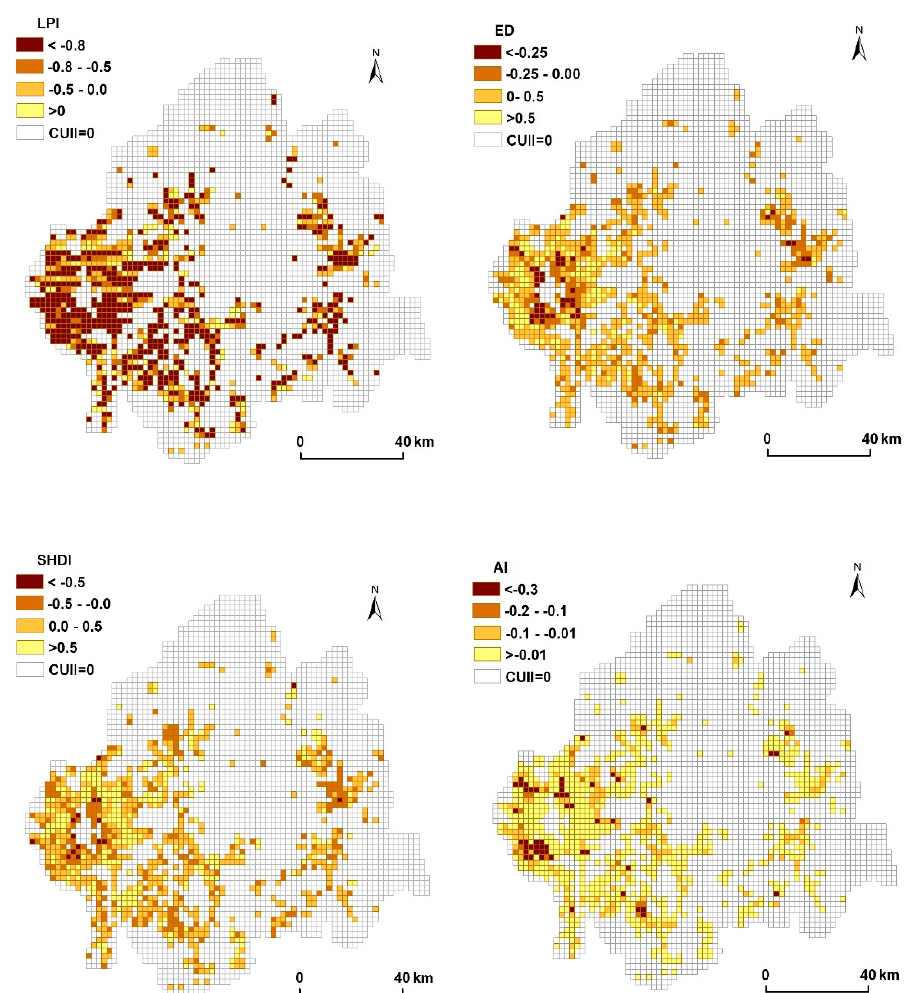
Figure 6. Change rates of soil landscape metrics during 2000–2015.